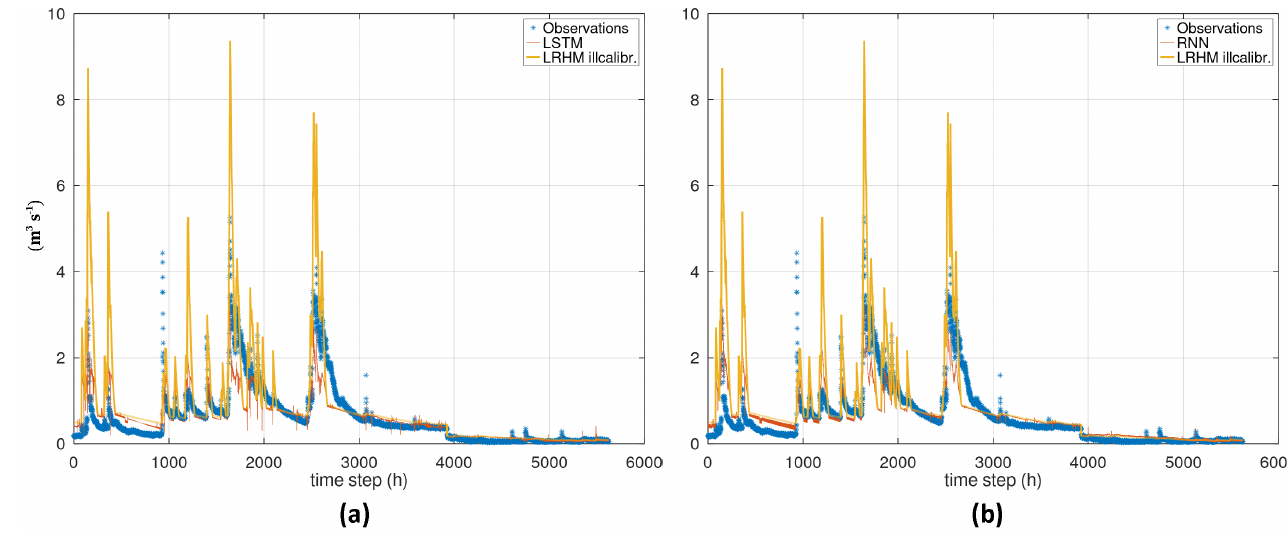
Figure 10. Assessment of the ill-calibrated hydrological model LRHM in Karveliotis. LSTM ( a ) and RNN ( b ) employed to approximate the best model that can be obtained with the available data employed during the test period. Table 3. Percentage improvement of the performance of the ML approximator over the calibrated and ill-calibrated LRHM hydrological model in the Karveliotis case study. Train Test LSTM RNN